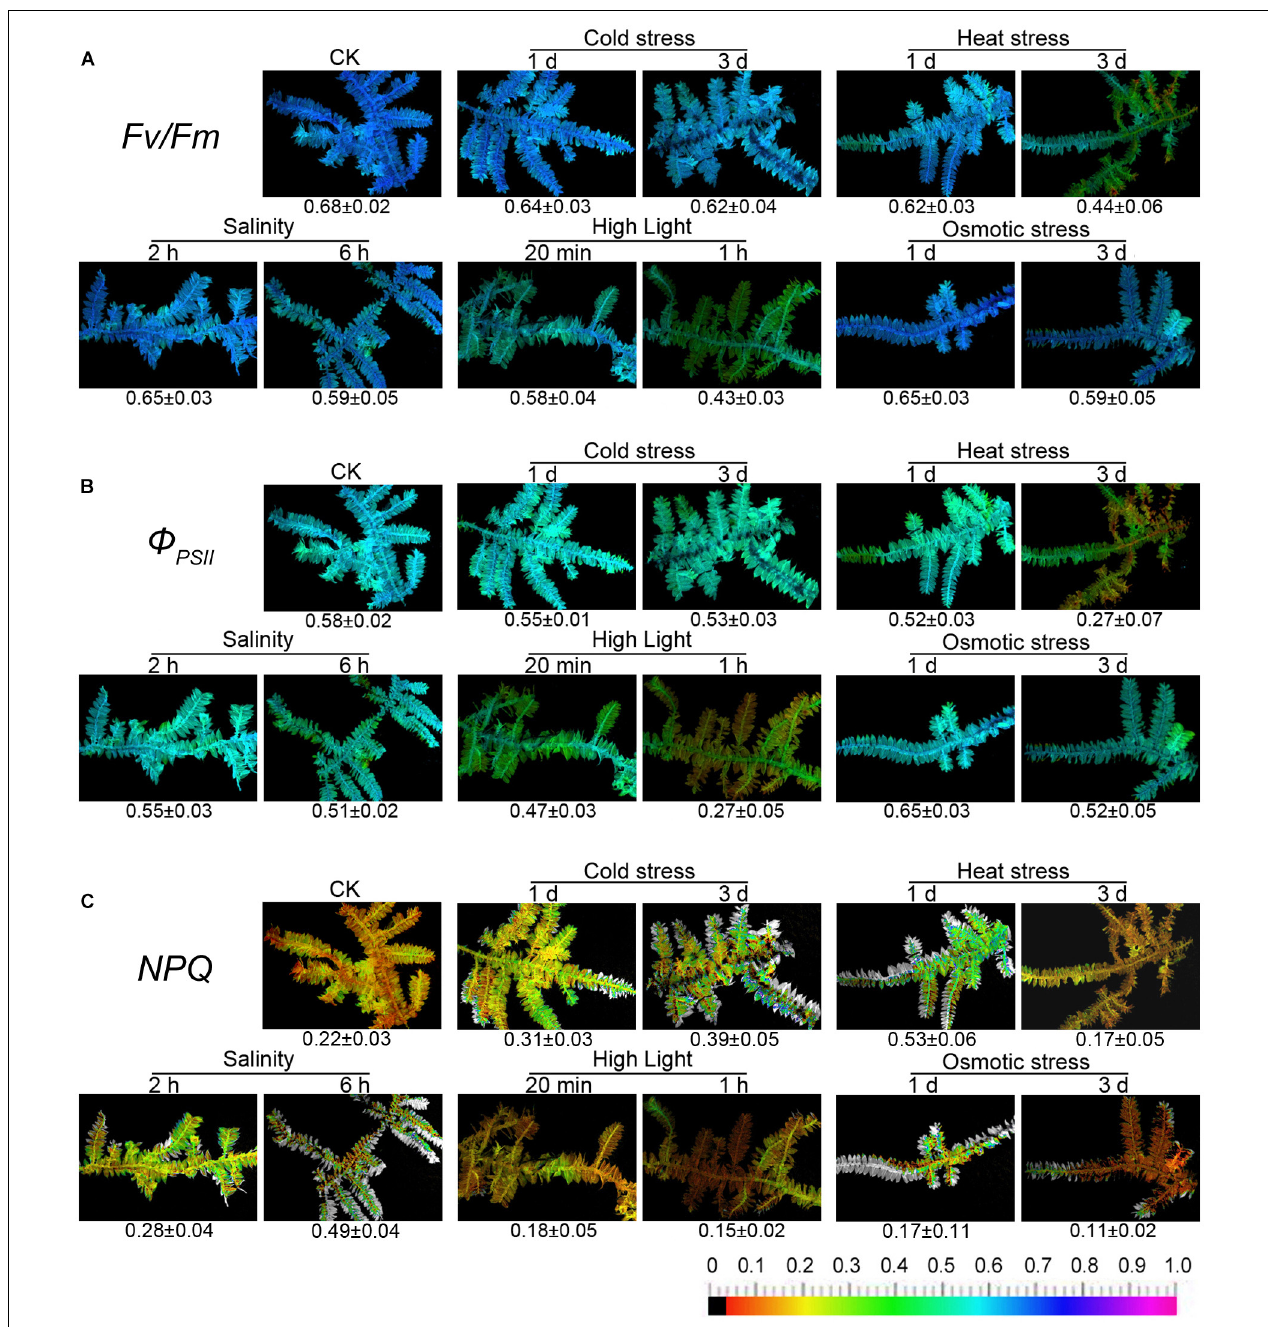
FIGURE 2 | Chlorophyll fluorescence imaging of T. taxirameum under cold stress, heat stress, salt stress, high light, and osmotic stress. Experimental materials were T. taxirameum (Mitt.) Fleisch, which were collected in Sichuan Agricultural University (Ya’an, China) and brought back to laboratory to be thoroughly washed. T. taxirameum were further acclimatized in distilled sterile modified Mohr medium for 3 days under the controlled conditions (16/8 h light/dark cycles at 100 µ mol of photons m − 2 s − 1 , 25 ± 1 ◦ C) before stress treatment. Adapted mosses were transferred to 10 ◦ C or 45 ◦ C 1 day/3 days for cold or heat stress. For salt stress, adapted mosses were placed in 300 mM NaCl solution for 2 or 6 h. For high-light stress, adapted mosses were placed at 1000 µ mol of light photons m − 2 s − 1 , 25 ± 1 ◦ C for 20 min or 1 h. Adapted mosses were placed in 20% PEG solution for 1 or 3 days for osmotic stress. Chlorophyll fluorescence images were obtained at room temperature using a modulated imaging fluorometer (the Imaging PAM M -Series Chlorophyll Fluorescence System, Heinz-Walz Instruments, Effeltrich, Germany) according to the instructions provided by the manufacturer. Images of Fv/Fm after dark adaptation and of (cid:56) PSII and NPQ at the steady-state of the induction curve with actinic illumination of 100 µ mol photons m − 2 s − 1 . The color scale shows at the bottom of the figure represents the range from 0 (black) to 1.0 (purple) for each parameter. (A–C) Means the three chlorophyll fluorescence parameters Fv/Fm, (cid:56) PSII , and NPQ respectively.